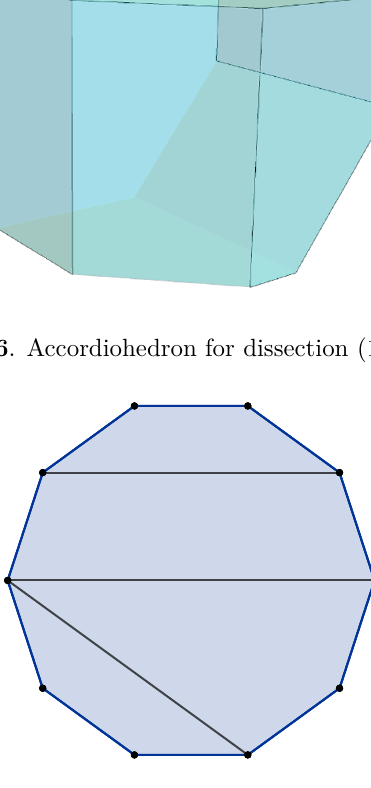
Figure 17 . Dissection (14 , 510 , 710)